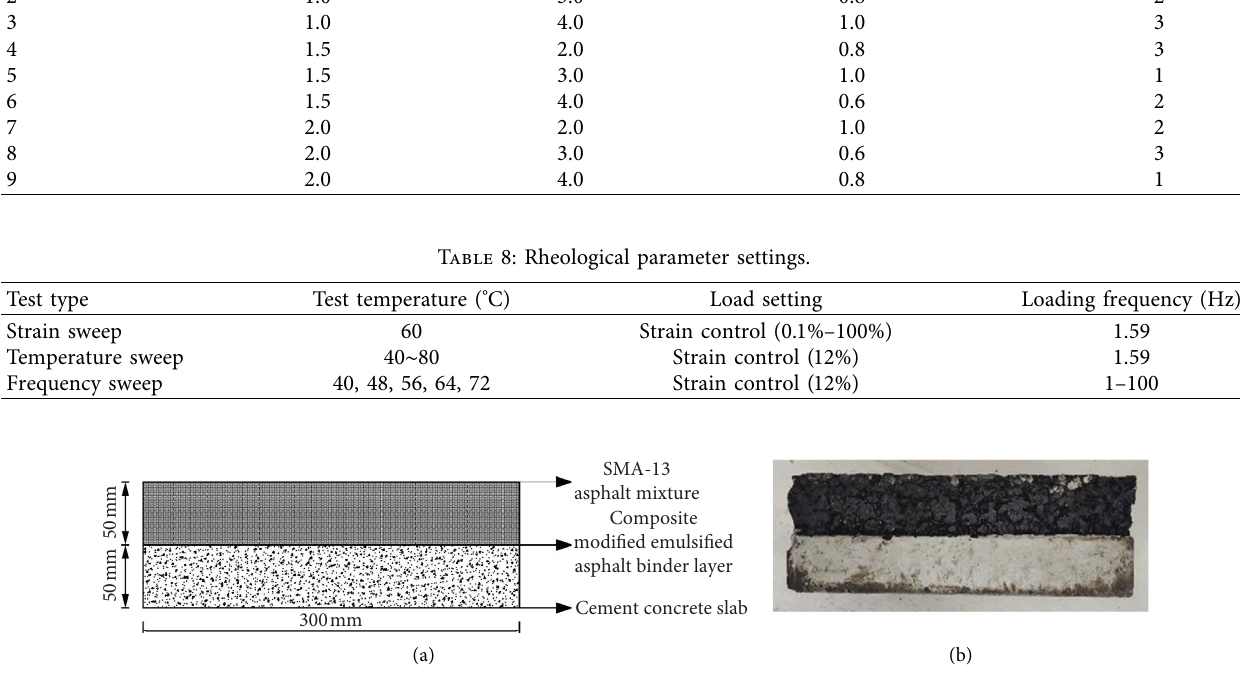
Figure 2: Composite concrete slab model and object. (a) Composite concrete slab model. (b) Composite concrete slab.